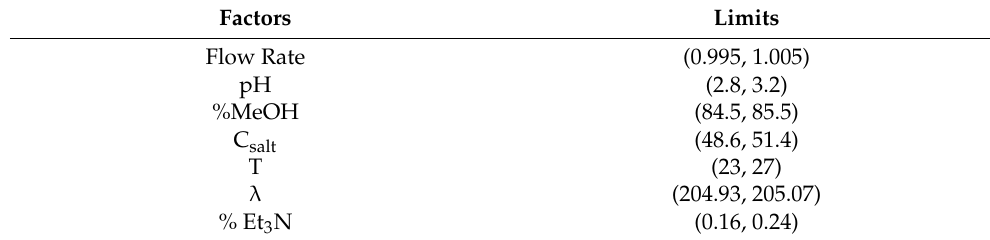
Table 10. Non-significant limits for each